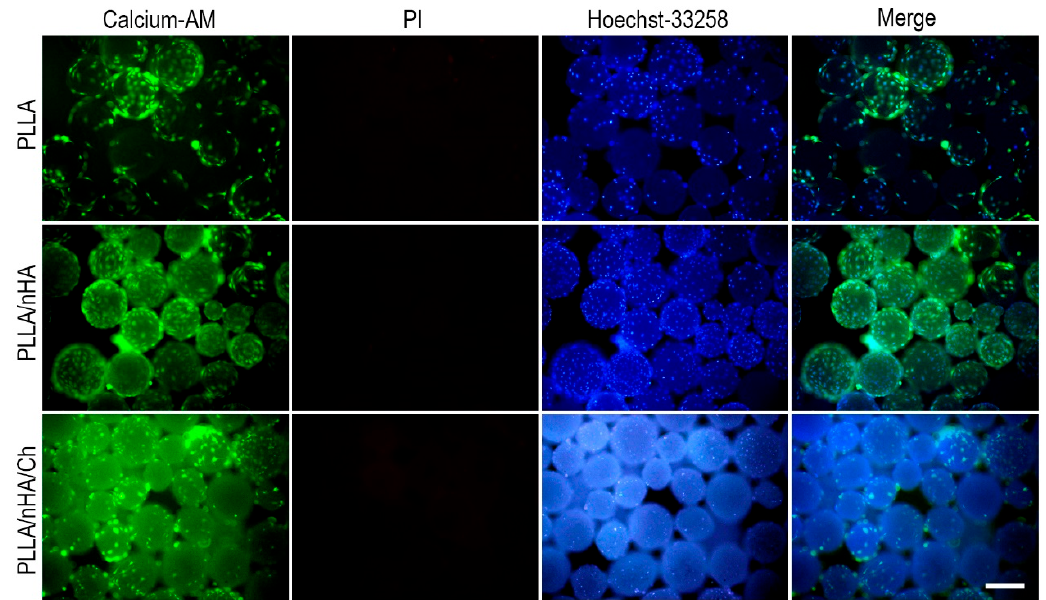
Figure 6. Live/dead staining of MC3T3-E1 cells of P7 passage cultured for 24 h on the surface of the three microcarriers, which were respectively the Calcein-AM, PI and Hoechst33258 staining, and their overlay composite graph. Scale: 250 μ m.